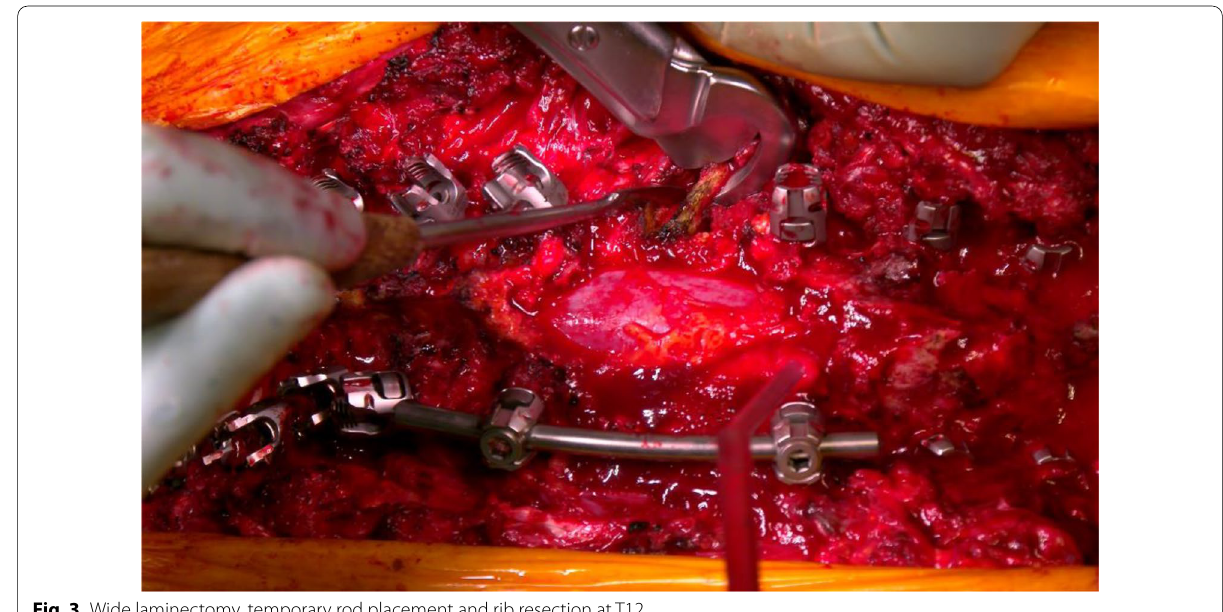
Fig. 3 Wide laminectomy, temporary rod placement and rib resection at T12